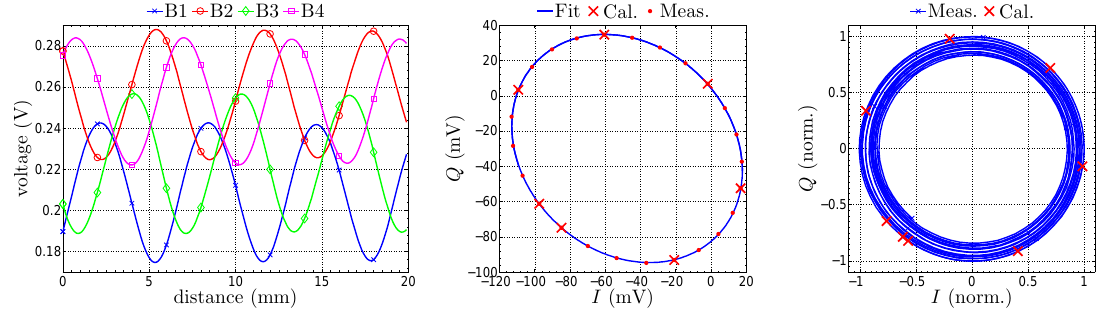
Figure 19. Measured baseband voltages, I/Q data and after equalization (from left to